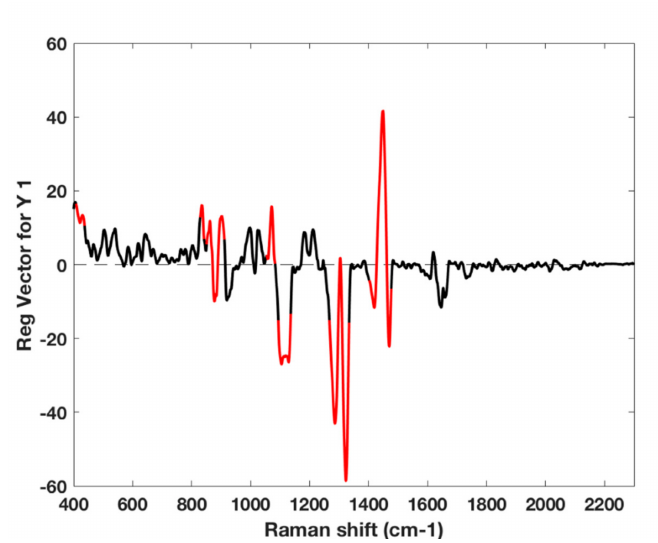
Figure 7. PLS calibration model for % rind content based on the updated calibration set (PR 1st + 6 PR 2nd): regression coe ffi cients with region with variable importance in projection (VIP) scores higher than one highlighted in